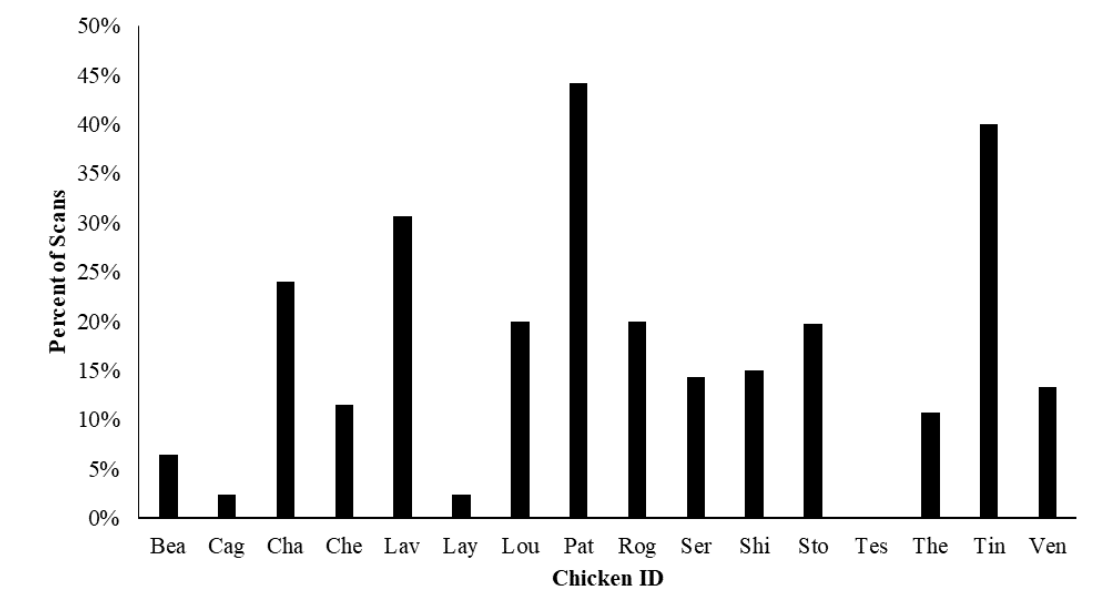
Individual Differences in the Percent of scans During which Chickens were Located in the Feeding Zone (the area Closest to Program Participants) During the Feeding